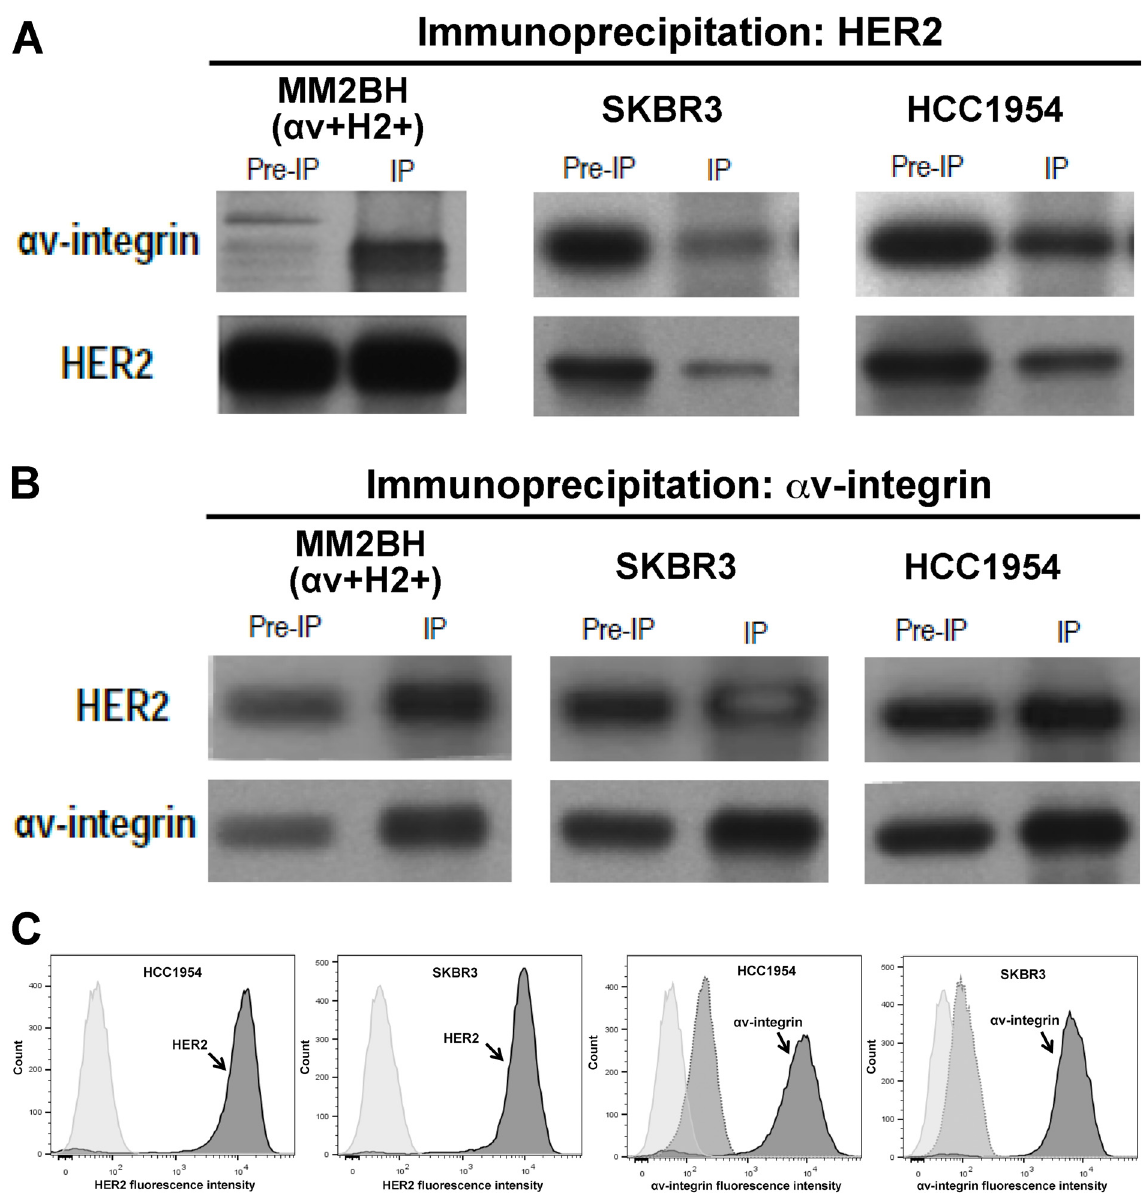
Fig 3. Co-immunoprecipitation of α v-integrin and HER2 proteins in breast cancer cells. Lysates from the SKBR3, HCC1954, and α v+H2+ MM2BH cells was incubated separately with antibodies against HER2 (A) and α v-integrin (B). Components of the immunocomplex precipitate were analyzed by Western blotting for α v-integrin and HER2 proteins. Protein levels are shown in whole lysate (pre-IP), and the immunoprecipated protein complex (IP). (C) Flow cytometry confirmation of HER2 and α v-integrin expression (arrows) in HCC1954 and SKBR3 cells. Light gray peak is unstained control and medium grey is secondary antibody only